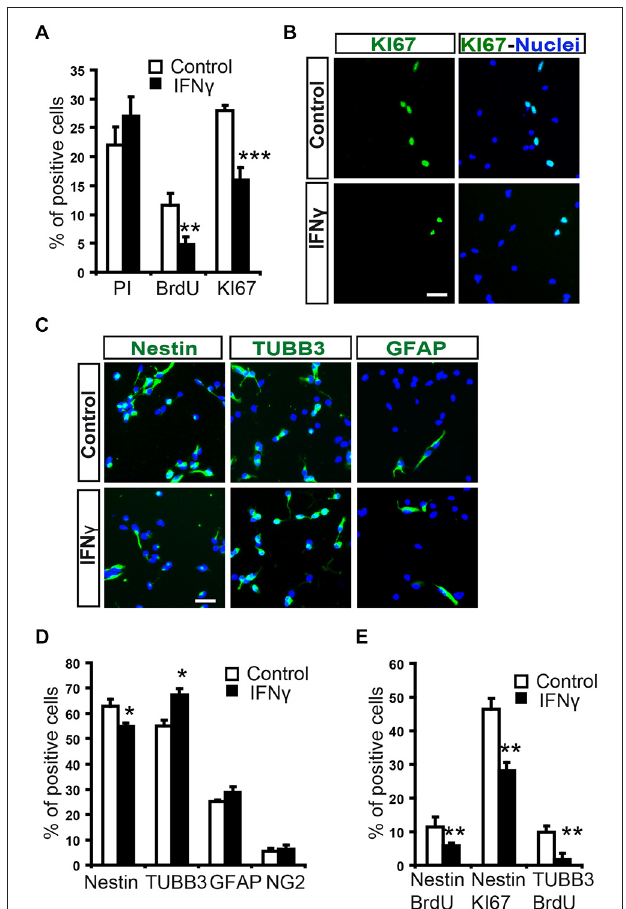
FIGURE 2 | In SVZ neural progenitors, IFN γ inhibits cell proliferation, while increasing neuroblast numbers. (A) Histograms showing percentage cell viability (IP), proliferation (BrdU) and number of cells in active cycle (Ki67) in the presence or absence of IFN γ (50 ng/ml) in SVZ primary cultures. IFN γ did not alter cell survival, but reduced cell proliferation (BrdU+) and the number of Ki67+ cells ( n = 7). (B) Immunofluorescence pictures of primary SVZ cultures illustrating the reduction of cells in active cell cycle (KI67+) after IFN γ treatment ( n = 7). Hoechst (blue) stained all nuclei. (C) Immunofluorescence pictures of SVZ primary cultures illustrating the decrease of Nestin+ progenitors (red) and the increase in neuroblasts (TUBB3+, red) after IFN γ treatment for 4 days ( n = 6). The number of GFAP+ cells remained unchanged. Hoechst (blue) stained all nuclei. (D) Graph summarizing the presence of cellular markers after IFN γ treatment. The numbers of TUBB3+ cells increased, while Nestin+ cells decreased in the presence of IFN γ (as percentage of total cells). Glial markers such a GFAP and Olig2 were unchanged ( n = 6). (E) IFN γ cultures exhibited a consistent decrease in the number of Nestin/BrdU+ and TUBB3+/BrdU+ cells ( n = 6), and a lower proportion of cells which expressed Nestin were in active cell cycle (Ki67+, n = 6). Scale bar (B, C) : 30 µ m. Data are represented as mean ± SEM. * p < 0.05; ** p ≤ 0.01; *** p ≤